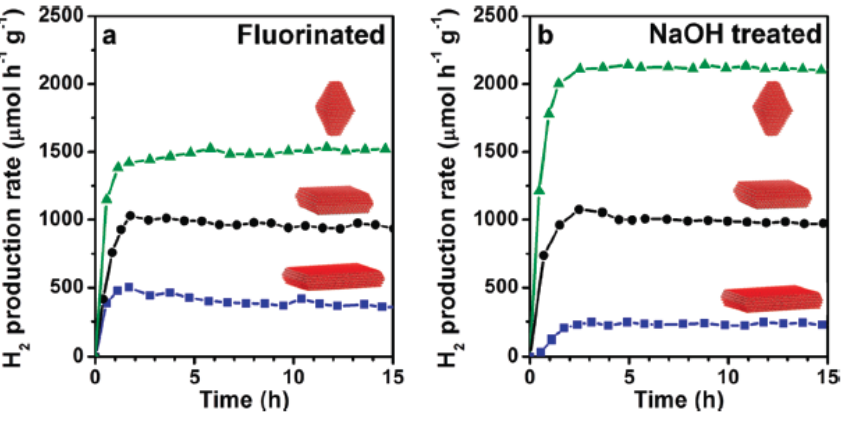
Figure 17. Hydrogen production rate from 1 wt.% Pt loaded samples of ligand exchanged, ( a ) fluorinated and ( b ) NaOH-treated TiO nanocrystals under solar illumination in 1:1 2 MeOH/H O mixtures. Reprinted with permission from ref. [115]. Copyright 2012 2 American Chemical